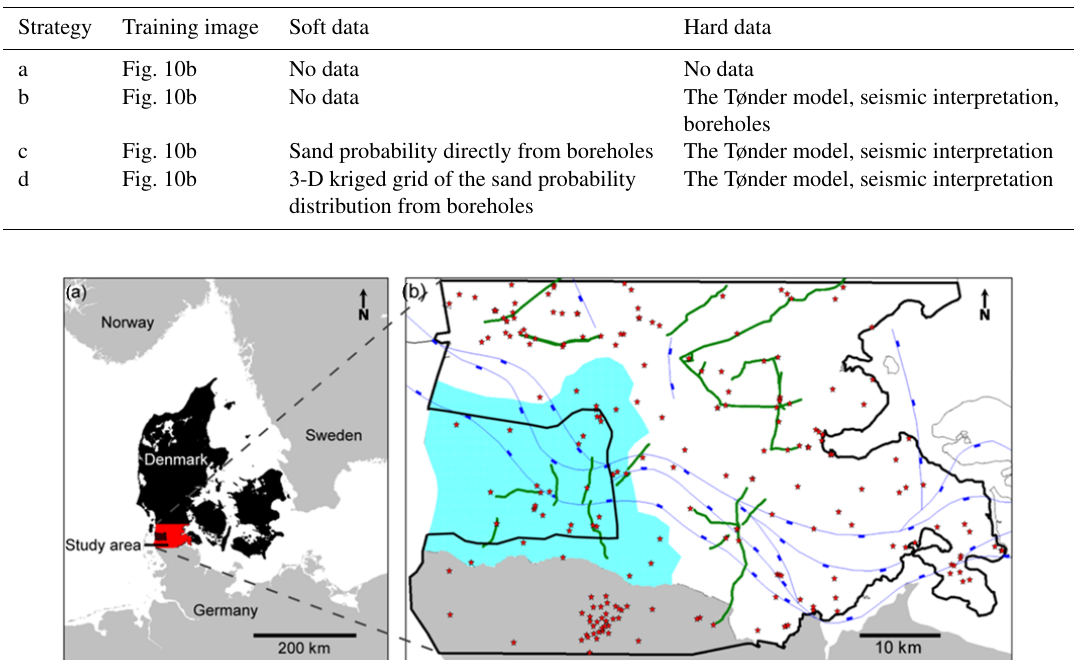
Table 1. The different conditioning strategies tested in this study. The corresponding realizations are presented in Figs. 15–17.